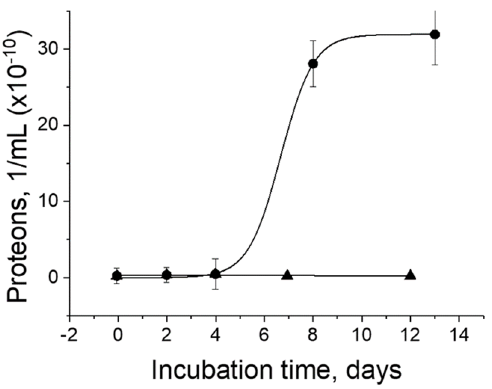
Figure 2. Proliferation of proteons. Proteons ( ) were incubated in the tissue culture media (